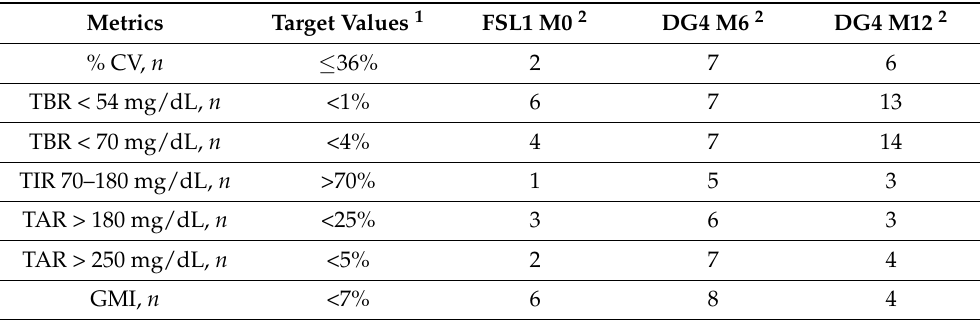
Table 3. Number of patients achieving the targets recommended by the ATTD consensus for glucose metrics using FSL1 then switching to